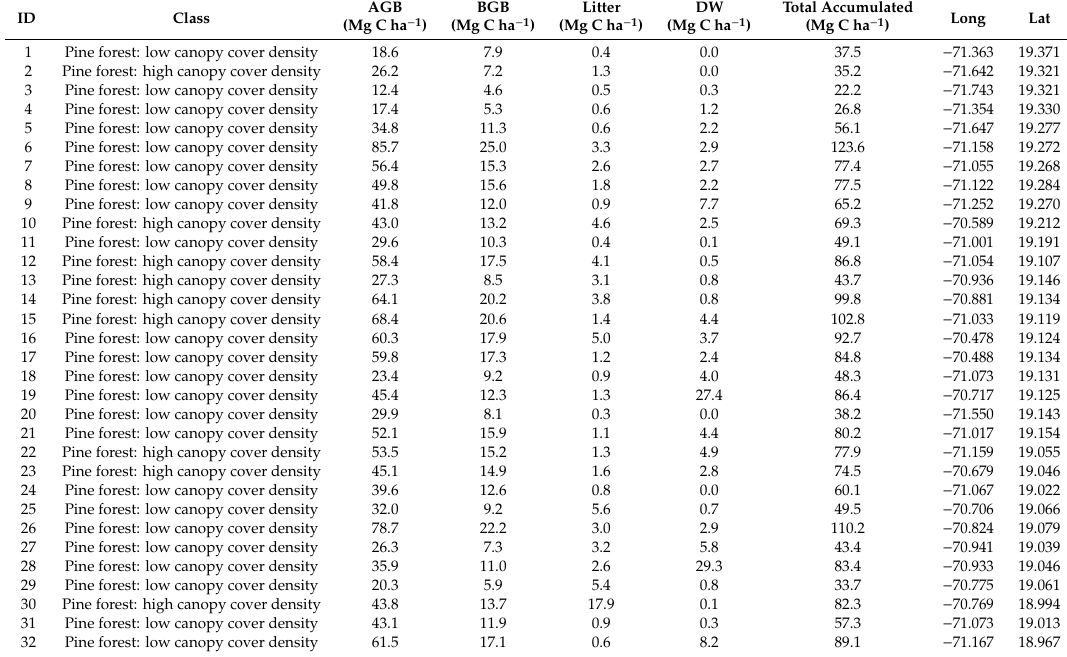
Table A2. Reference field: National Forest Inventory (NFI) collected by the Ministry of the Environment and Natural Resources (MARN) of the Dominican